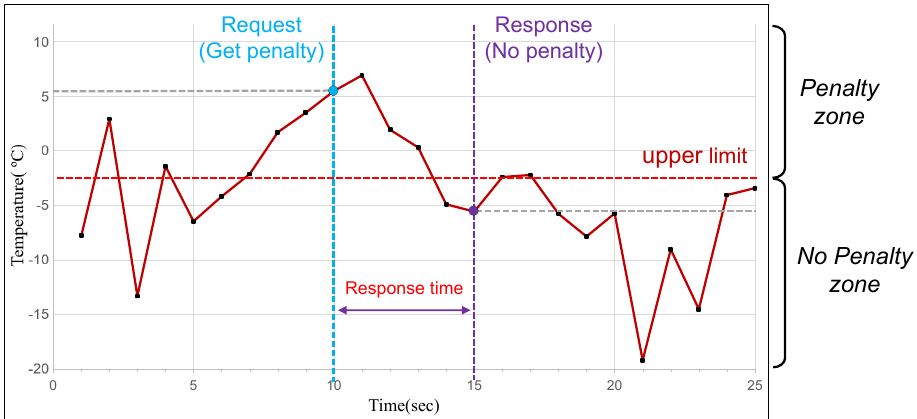
Figure 3. Time-Variant IoT Data in